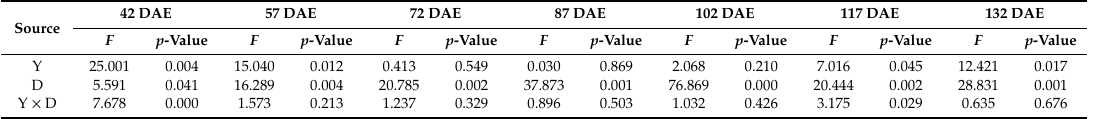
Table 9. Analysis of variance for the effect of year (Y) and plant density (PD) on leaf area index. Source